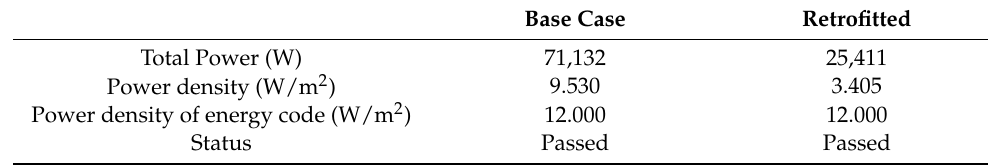
Table 14. Evaluated results of the lighting system in comparison with building energy code.